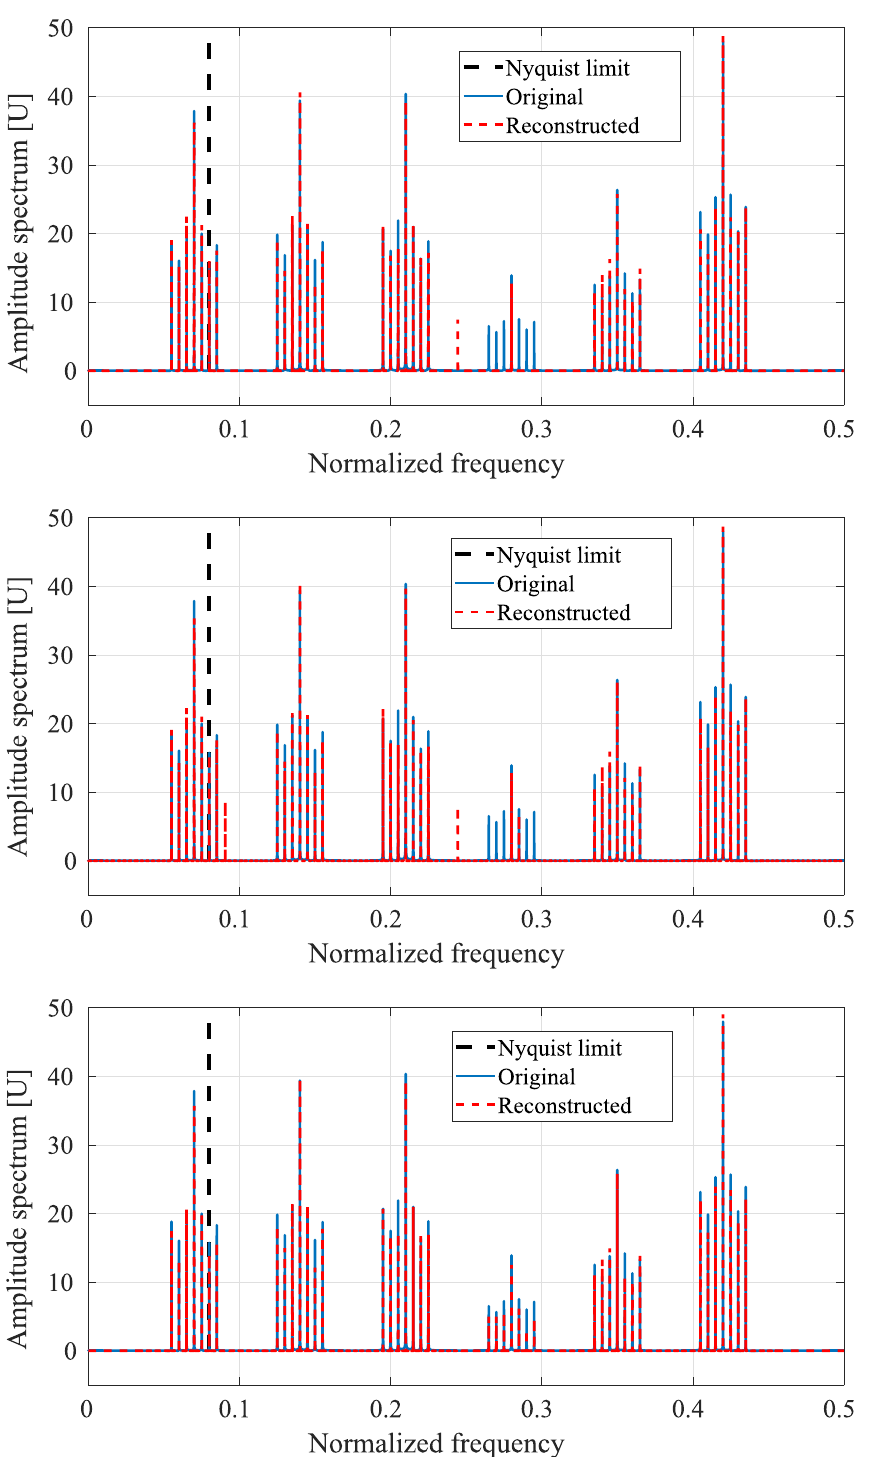
Figure 5. Reconstructed spectra using (from top to bottom) t-univ, H-univ, and SMG-block for compression rate 0.85 and noise level 0 dB